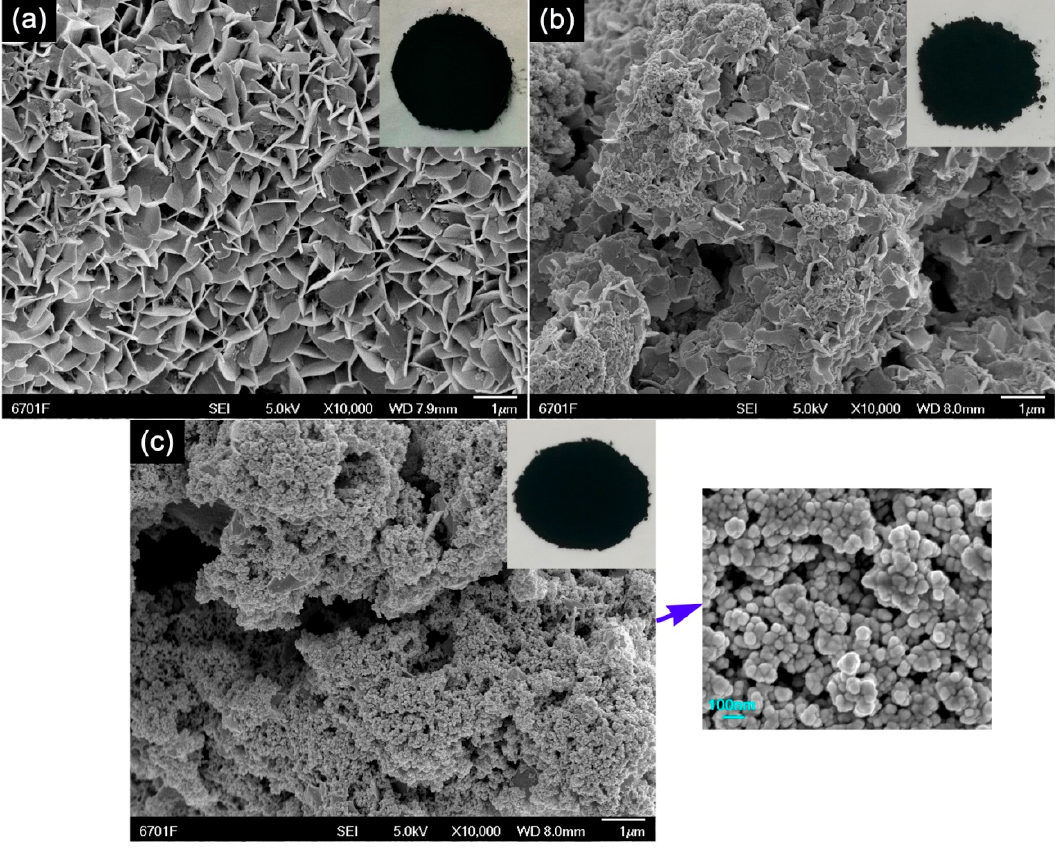
Figure 2. SEM images of CuS samples synthesized at different reaction temperatures for 10 h. ( a ) 10